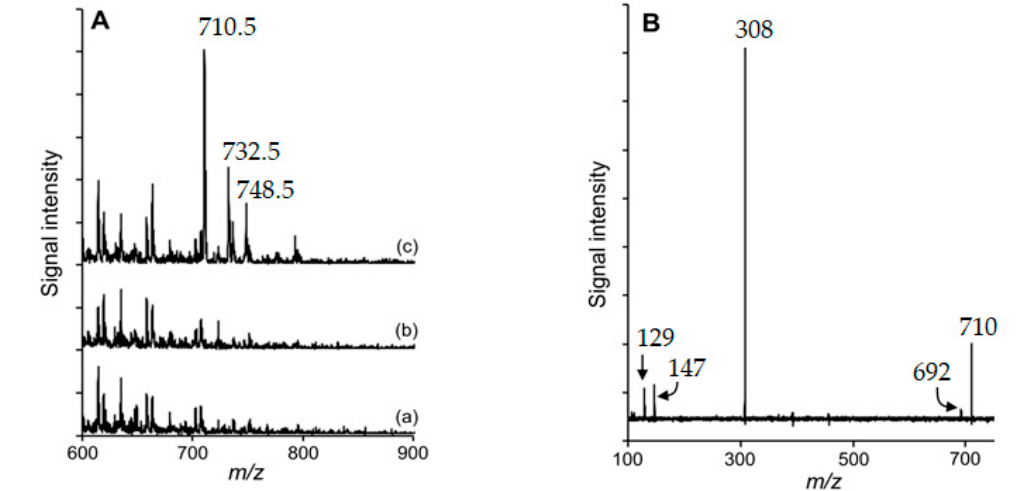
Figure 5. Mass spectrometry (MS) spectra recorded during high-performance liquid chromatography (HPLC)-MS/MS measurements at the retention time of the reaction product between cholesterol-5 α ,6 α -epoxide and N α -benzoylglycyl- L -lysine ( m/z 710.5). ( A ) HPLC-MS/MS measurements of (a) cholesterol-5 α ,6 α -epoxide, (b) N α -benzoylglycyl- L -lysine, and (c) a mixture of cholesterol-5 α ,6 α -epoxide and N α -benzoylglycyl- L -lysine, each heated at 180 °C for 120 min; ( B ) product ion spectrum (parent ion, m/z = 710.5 ± 0.5; fragmentor voltage, 135 V; collision energy, 30 V) of the reaction product from the mixture of cholesterol-5 α ,6 α -epoxide and N α -benzoylglycyl- L -lysine that had been heated at 180 °C for 120 min.